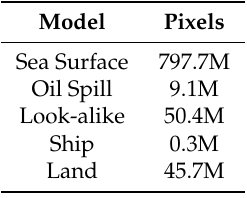
Table 1. Number of pixels for each